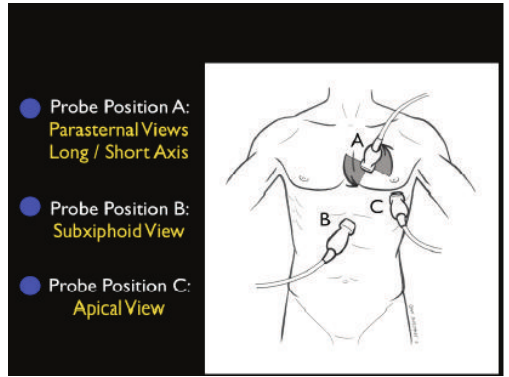
Figure 1: The RUSH exam. Step 1: Evaluation of “the pump”.